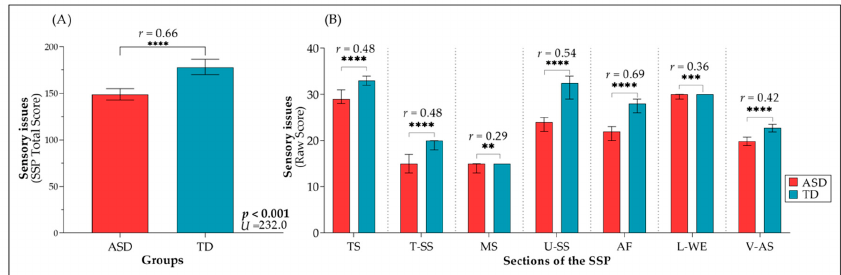
Figure 2. Sensory processing comparison between children with ASD and TD children: (A) Total Score of Short Sensory Profile-SSP by groups; (B) Raw scores across the seven sections of the SSP by groups.